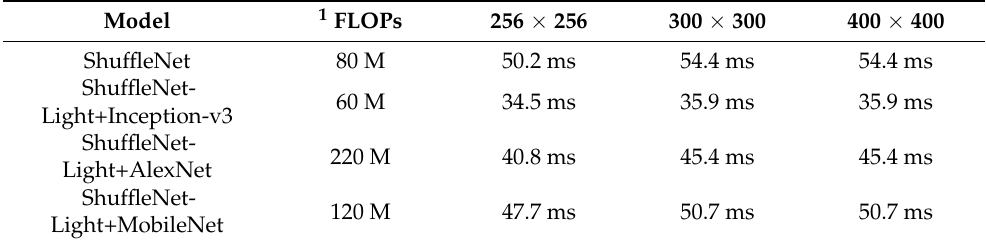
Table 10. Performance of the proposed ShuffleNet-Light model on an Android mobile device.